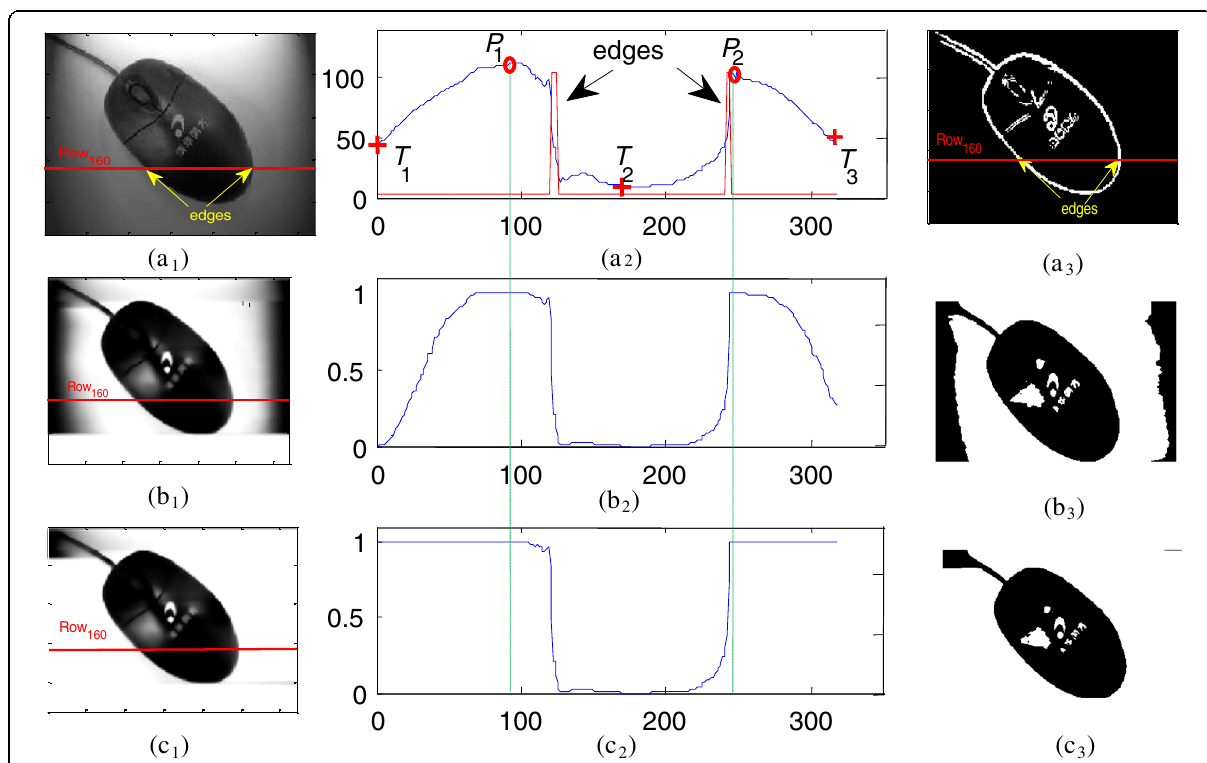
Fig. 7 a 1 The mouse image. a 2 The gray wave curve (the blue curve) and the edge information (the red curve) of the 160th row for the mouse image. a 3 The edge information obtained by the Sobel operator. b 1 – c 1 The gray wave transformation image before and after adding the edge information by Eq. (19) in the horizontal direction. b 2 – c 2 The gray wave curve of the 160th row before and after adding the edge information by Eq. (19) in the horizontal direction. b 3 – c 3 The segmented images before and after adding edge information T = 800, α =